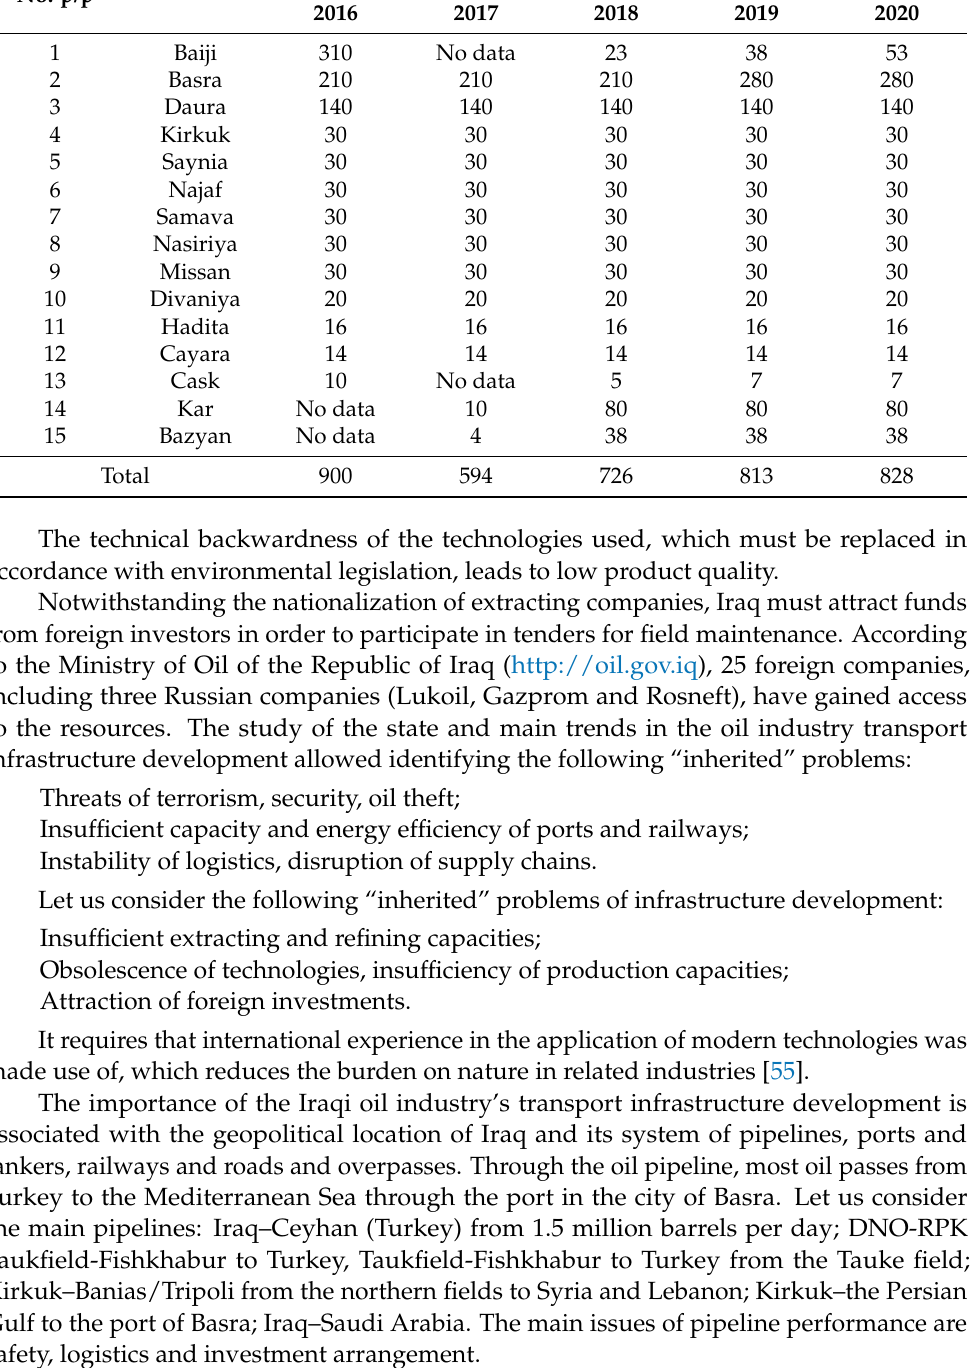
Table 3. Dynamics of capacity of oil refineries in Iraq, thousand barrels/day, 2016–2020 years. No.